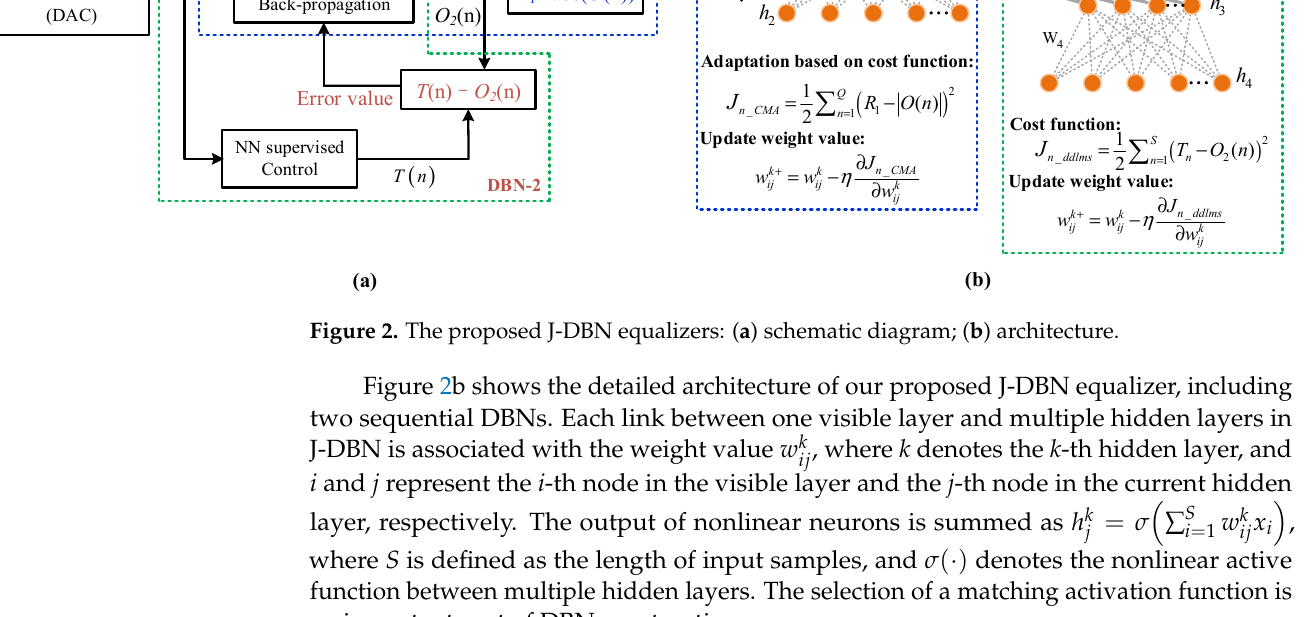
) =  Nk k k 1 + v w v , where k v is the output of the j ij ji = j , where k denotes the k -th hidden layer, and ij (cid:17) (cid:16) h as the final output signal calculated from the ∑ S = σ w k x i j i = 1 j ij